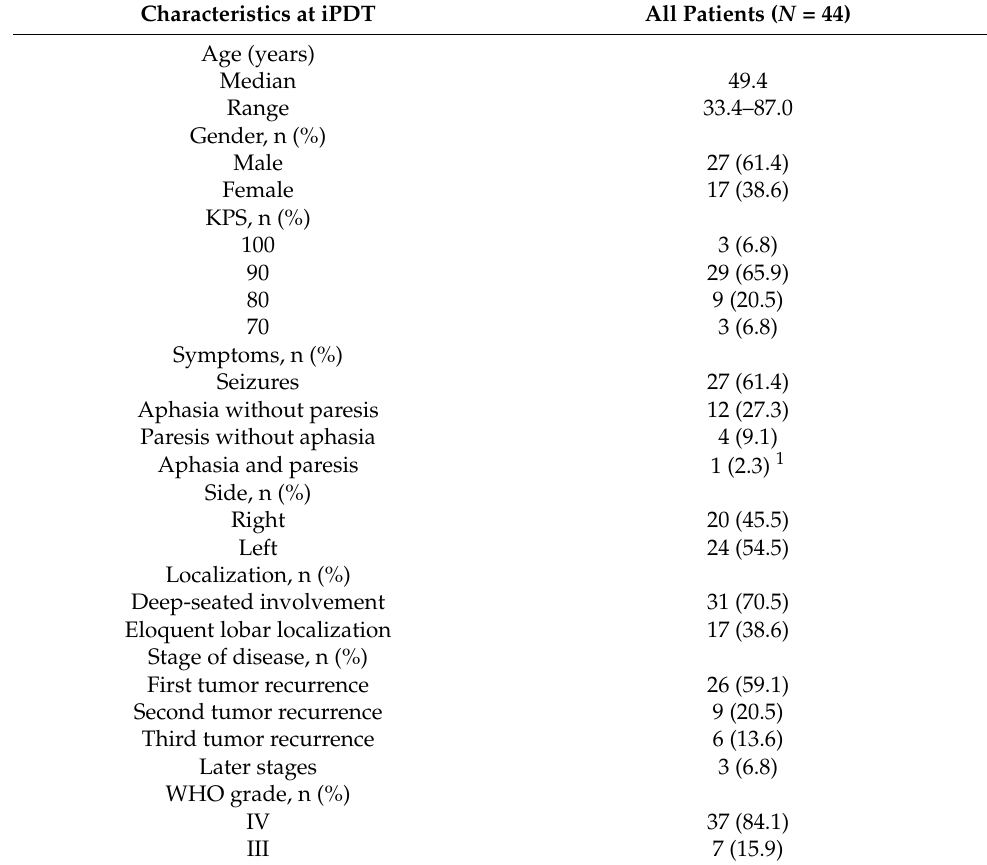
Table 1. Summary of patients’